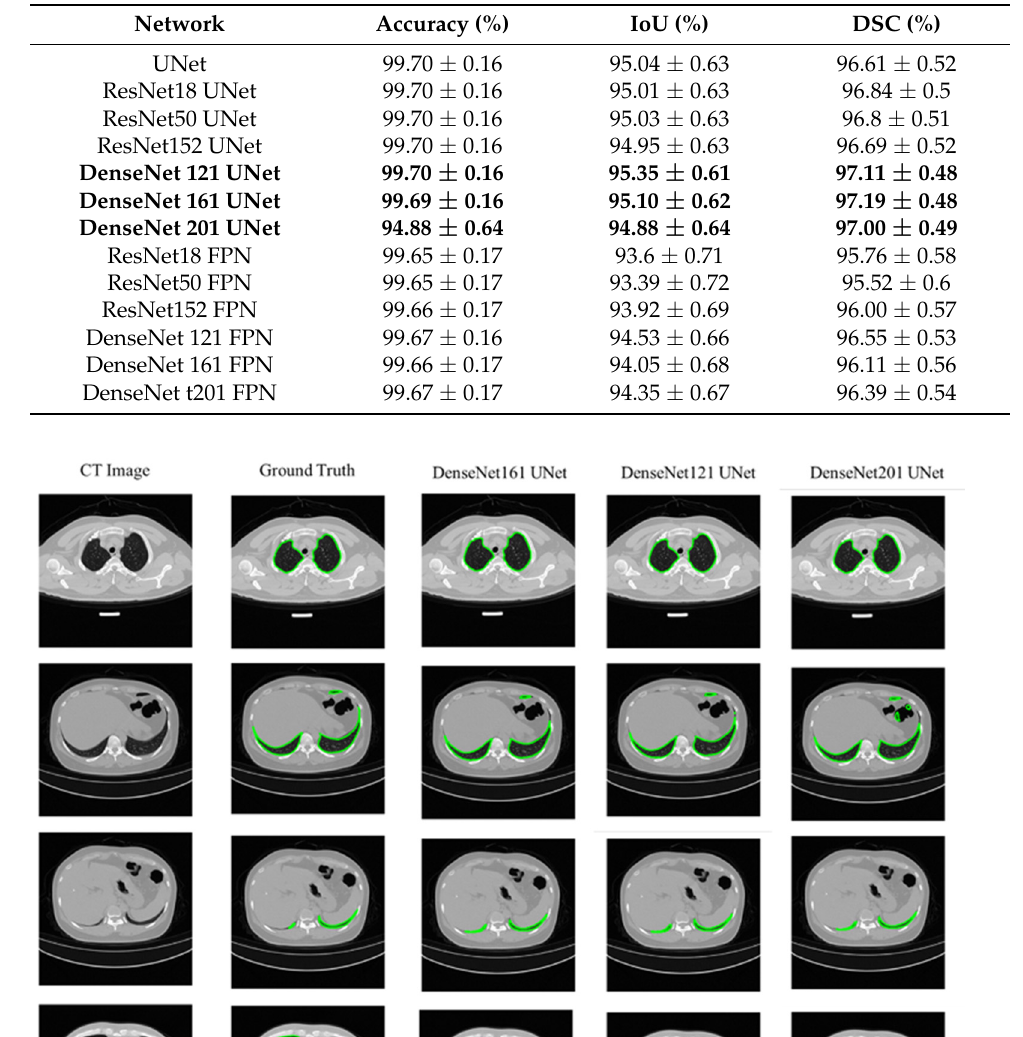
Table 6. Results of 10-fold cross-validation of Lesion Segmentation (Best results are formatted in Bold).